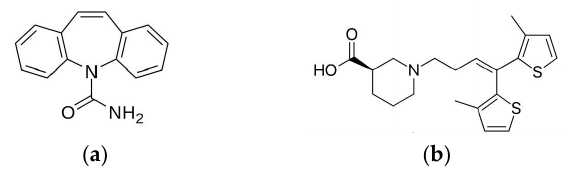
Figure 1. Chemical structures of ( a ) carbamazepine and ( b ) tiagabine.